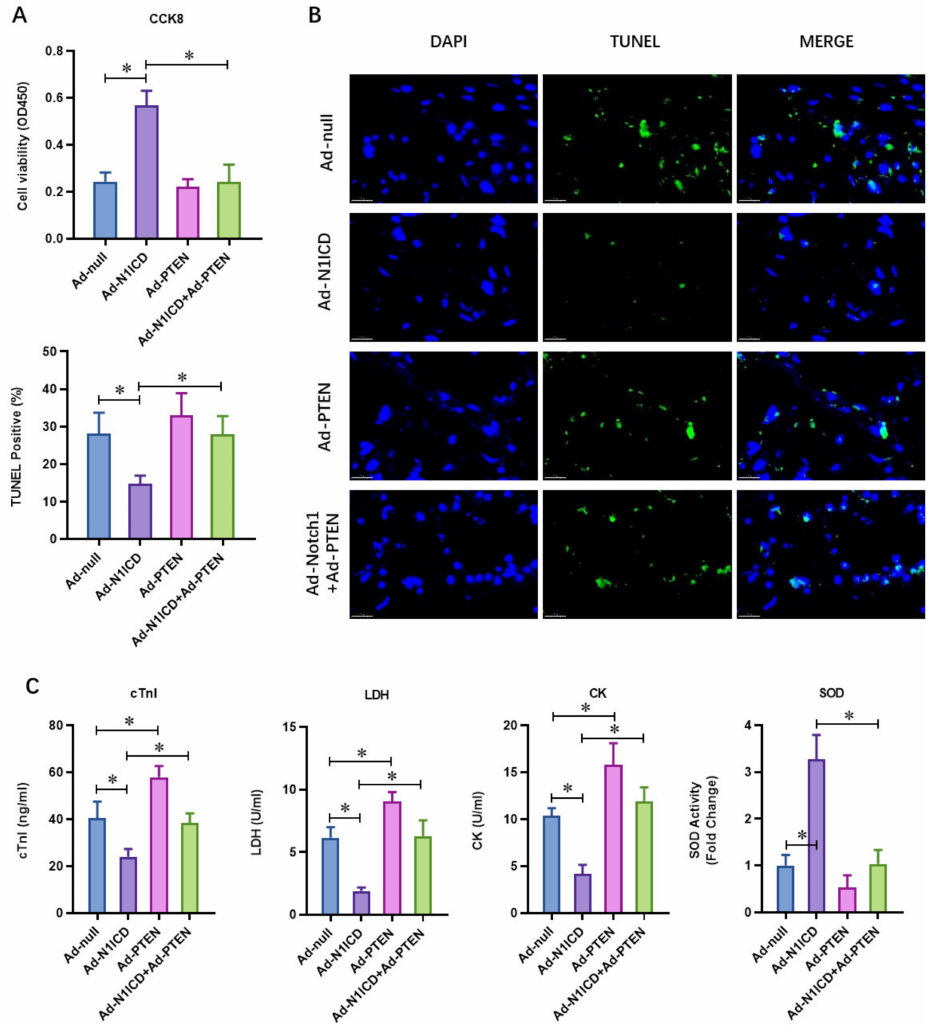
Figure 2. PTEN over-expression impaired the protective effect of N1ICD against hypoxia/reoxygenation-induced injury in neonatal cardiomyocytes. ( A ) The cellular viabil- ity was detected by CCK-8 assay; ( B ) the percentage of apoptotic neonatal cardiomyocytes was analyzed by TUNEL staining; ( C ) the level of cTnI, LDH, CK and SOD in the culture medium was also detected by ELISA kits at the end of the reperfusion to assess myocardial injury; N = 3; * p < 0.05 versus indicated